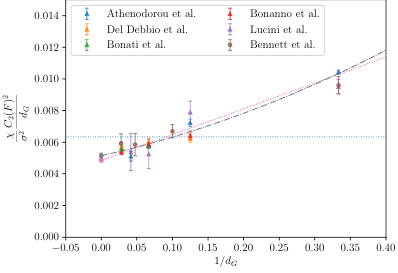
Figure 3. Topological susceptibilities χ in units of the string tension σ , rescaled by group factors C 2 ( F ) 2 / d G , for SU( N c ) and Sp( N c ) Yang-Mills as a function of the dimension of the group d G . The figure is taken from Ref. [15].